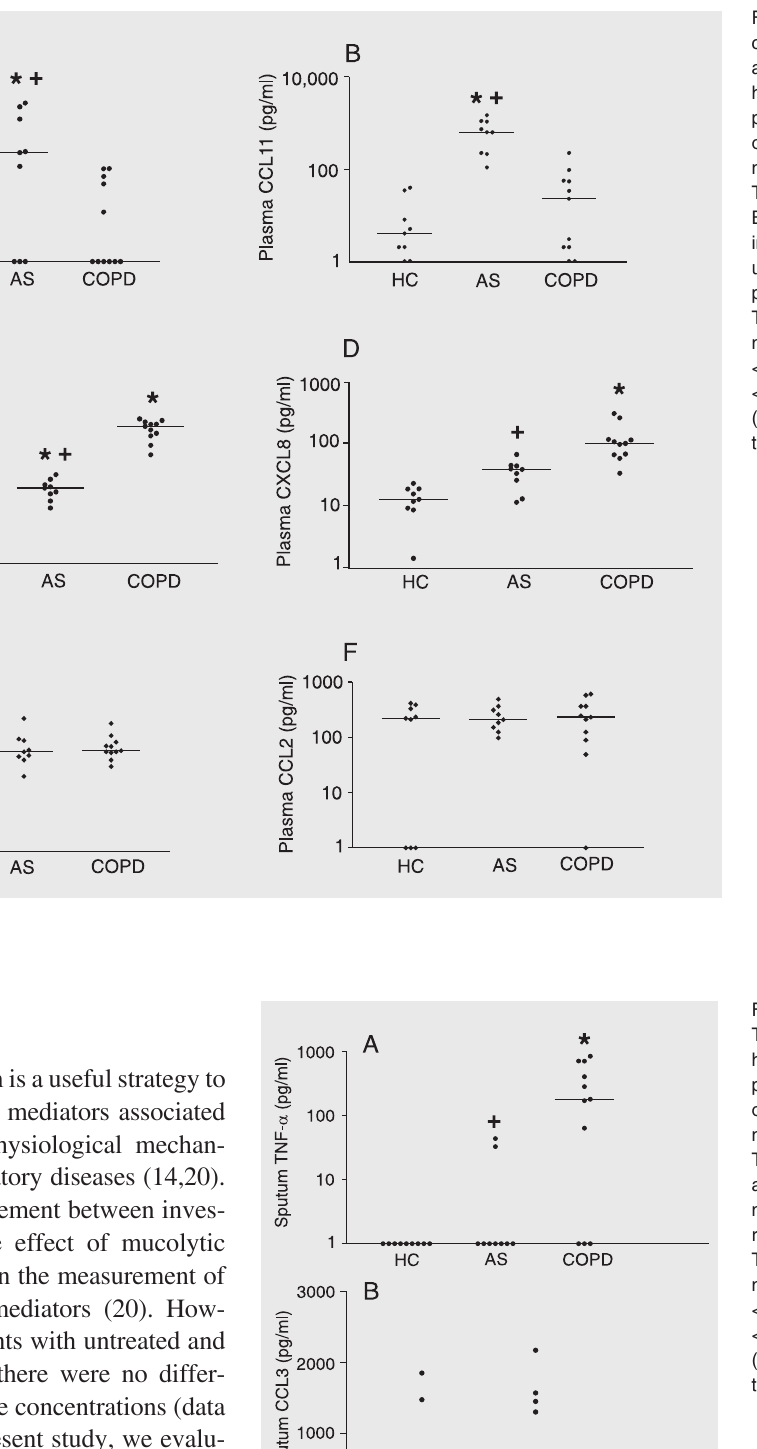
Figure 1. Concentrations of chemokines in sputum (left side) and plasma (right side) of healthy control (HC, N = 9) and patients with asthma (AS, N = 9) or chronic obstructive pulmo- nary disease (COPD, N = 11). The concentration of CCL11 (A, B), CXCL8 (C, D) or CCL2 (E, F) in sputum or plasma was meas- ured by ELISA. Data are re- ported as the log mean value. The horizontal lines indicate the median value for each group. *P < 0.05 compared to HC and + P < 0.05 compared to COPD (Spearman’s rank correlation test).